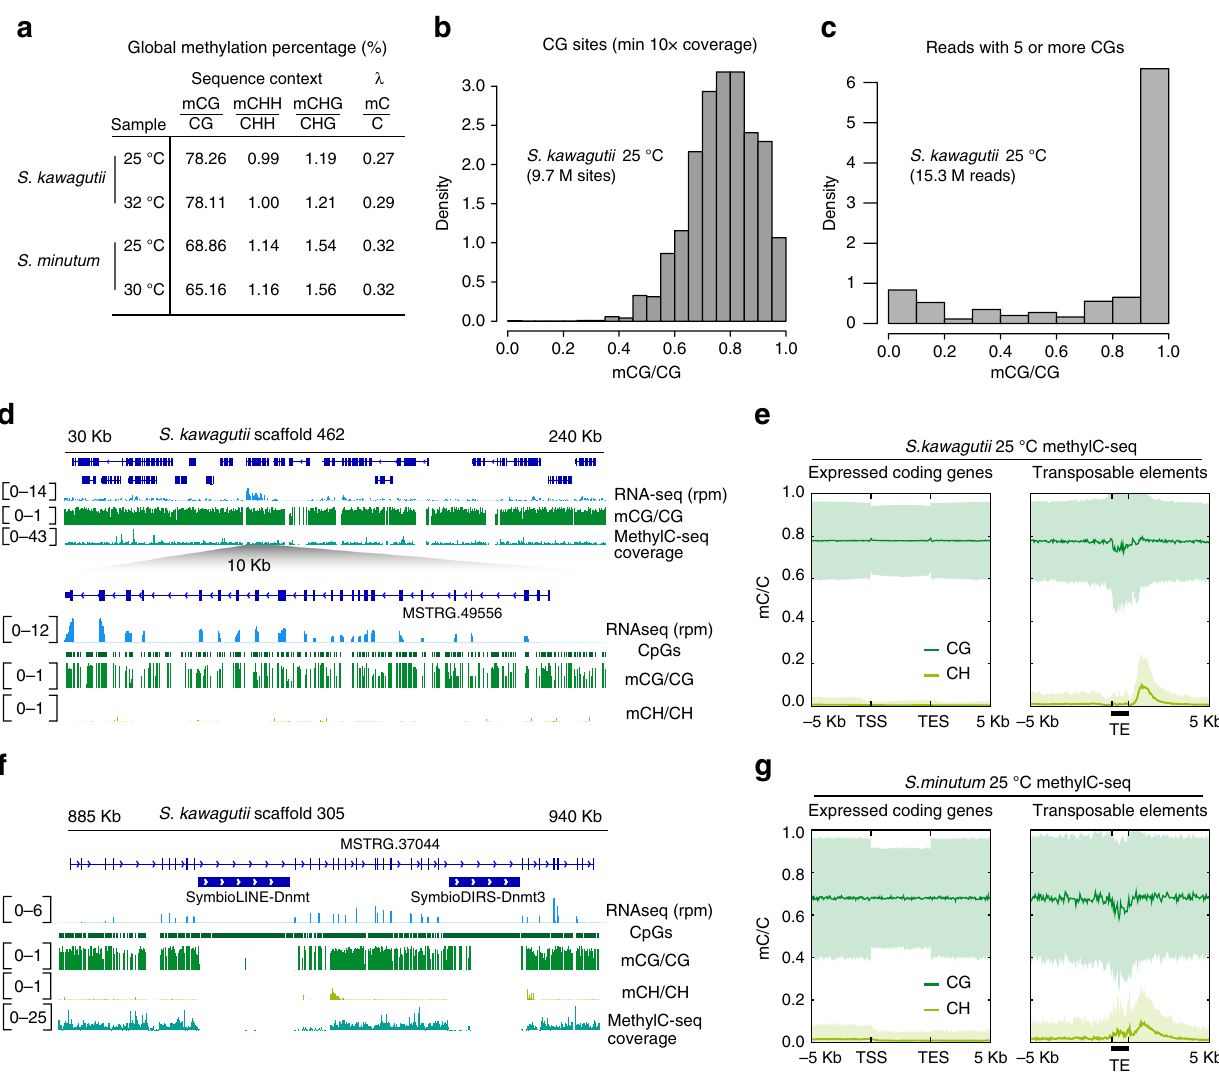
Fig. 3 Widespread CG and localised CH methylation in Symbiodinium . a Percentage of methylated cytosines in distinct sequence contexts in four MethylC- seq libraries. H represents any base but a G. The lambda genome methylation indicates the bisul fi te non-conversion rate for each library. b Unimodal distribution of methylation levels (the ratio of C base calls to total base calls) on individual CG sites with high coverage ( ≥ 10 reads) in S. kawagutii 25 °C culture sample. c Methylation level of mapped reads with ≥ 5 CGs in S. kawagutii 25 °C culture sample. d Genome browser display showing the pro fi le of methylation on genes expressed at different levels in a single scaffold. rpm reads per million. e Methylation pro fi les in CG and CH contexts on S. kawagutii genes and transposable elements. Mean (thick line) and standard deviation (shade) methylation levels for each relative position around genomic features. f Genome browser display demonstrating CH methylation enrichments on 3 ′ end of silent DNMT encoding retrotransposons found in introns of an expressed gene. g Methylation pro fi les in CG and CH contexts on S. minutum genes and transposable elements. Line represents mean and pale